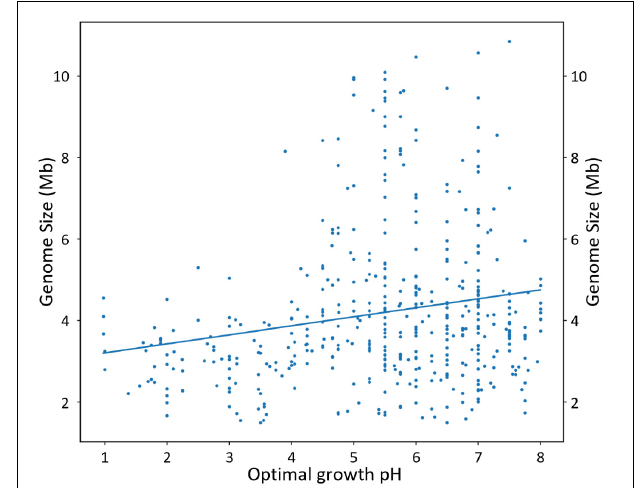
FIGURE 3 | Scatterplot of the genome size (Mb) of bacterial acidophiles and their most closely related extant, circum-neutral relatives vs. optimal growth pH. Each point corresponds to a different species. A linear regression curve has been fitted to the data with a Pearson’s correlation coefficient of 0.19 and a p -value of 2.97 × 10 − 5 . The generalized least squares p -value was 1.8 × 10 − 3